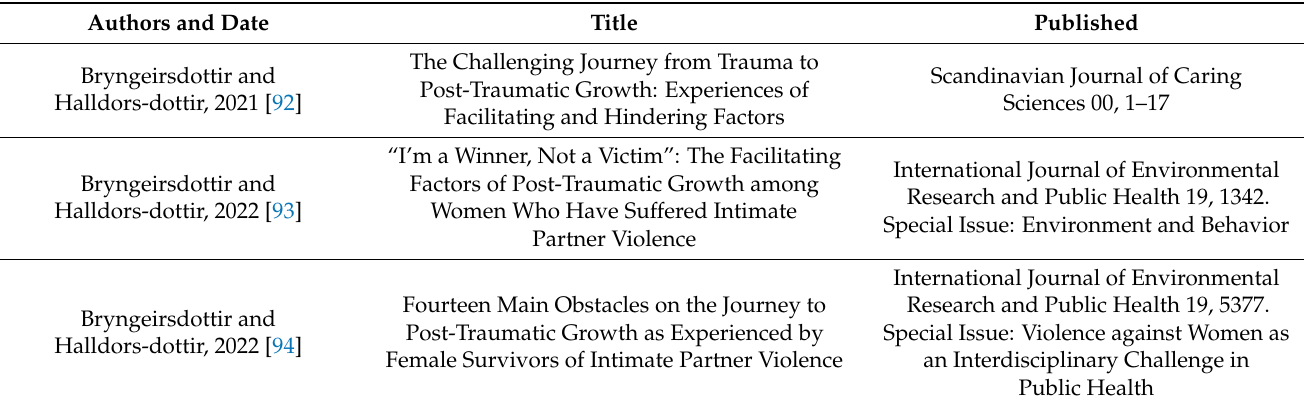
Table 2. The published studies used to develop the theory in step I.